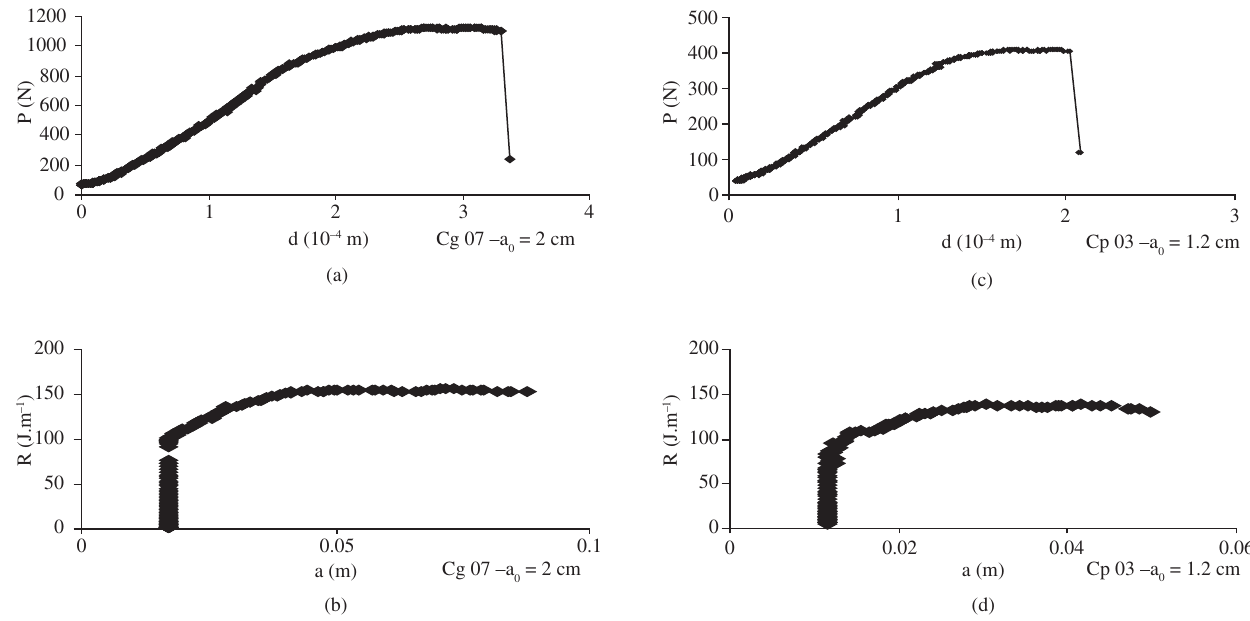
Figure 5. Graphs a-b) correspond to the large test specimens (CP Graphs a, c) are P x d graphs, while b,d) are the corresponding R-curve graphs.